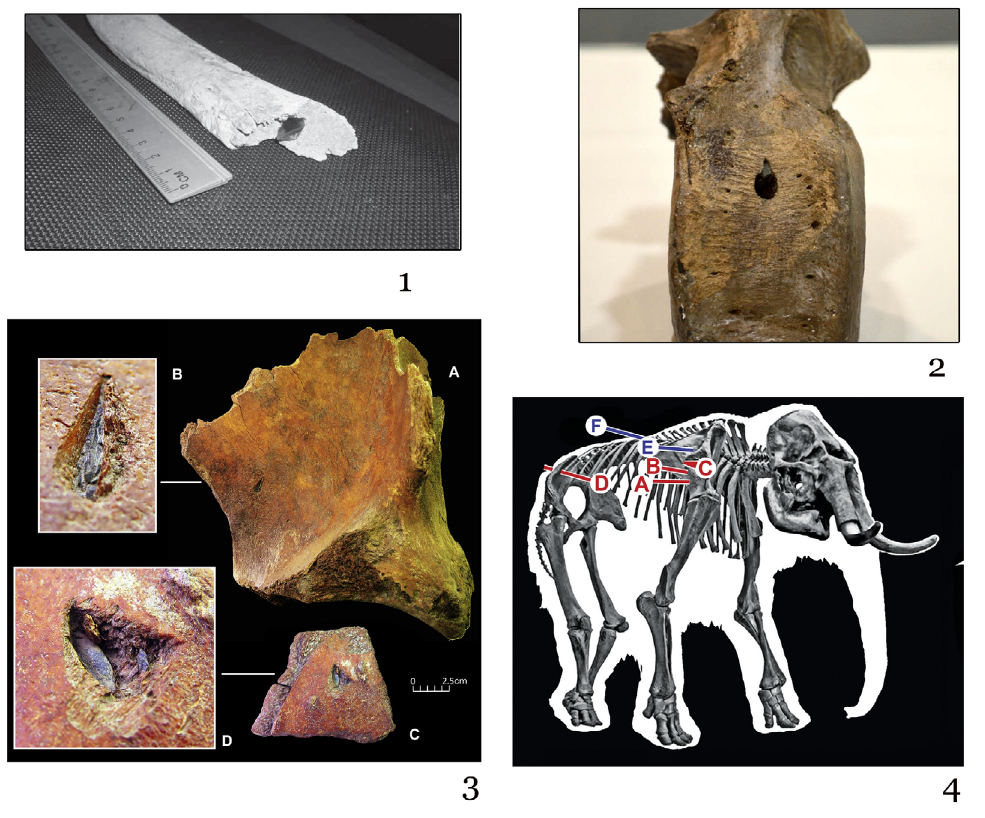
Figure 8. Examples of lithic points embedded in mammoth bones: 1) Kostenki 1 (Nuzhny et al., 2014), Lugovskoe (Zenin et al., 2006), Yana (Nikolskiy & Pitulko, 2013). Location of the injuries on the mammoth skeleton (modified from Nikolskiy & Pitulko,